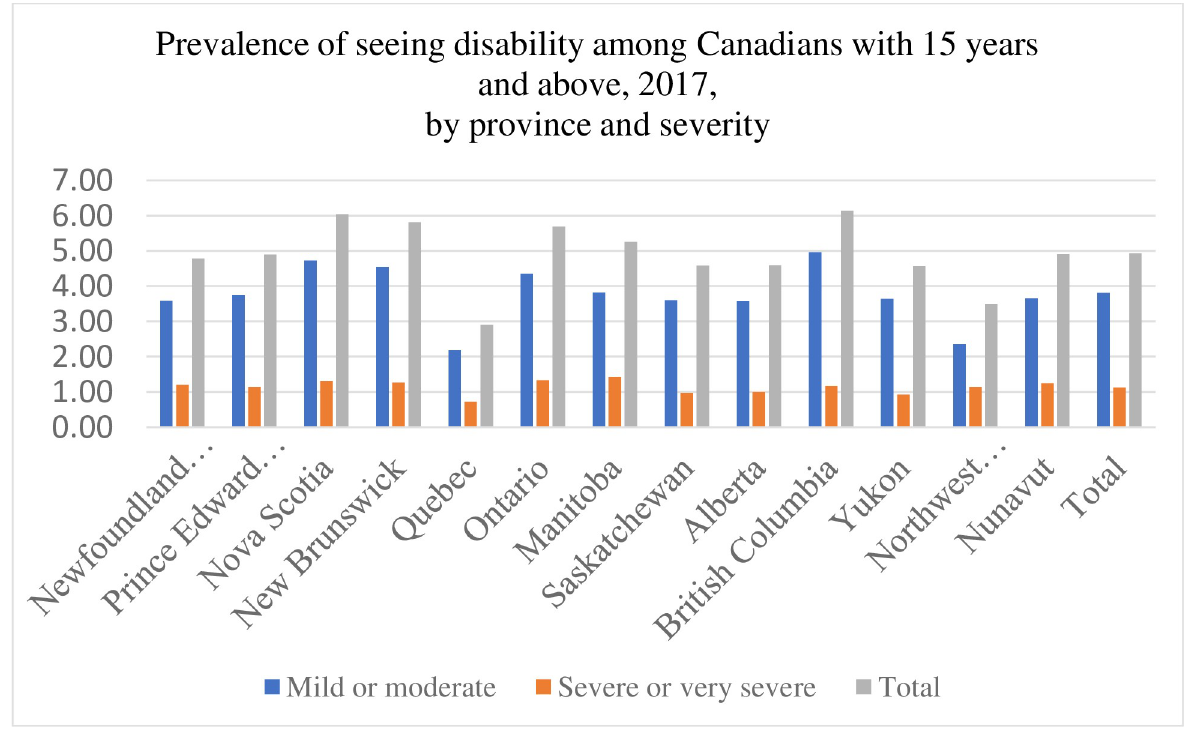
Fig 1. Prevalence of seeing disability across Canadian provinces,